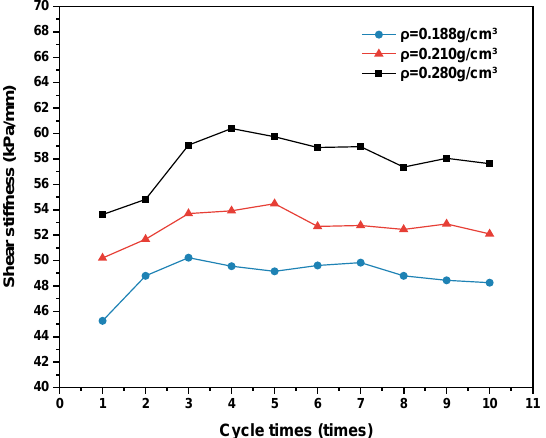
Figure 15. Development trends of shear stiffness with different densities.